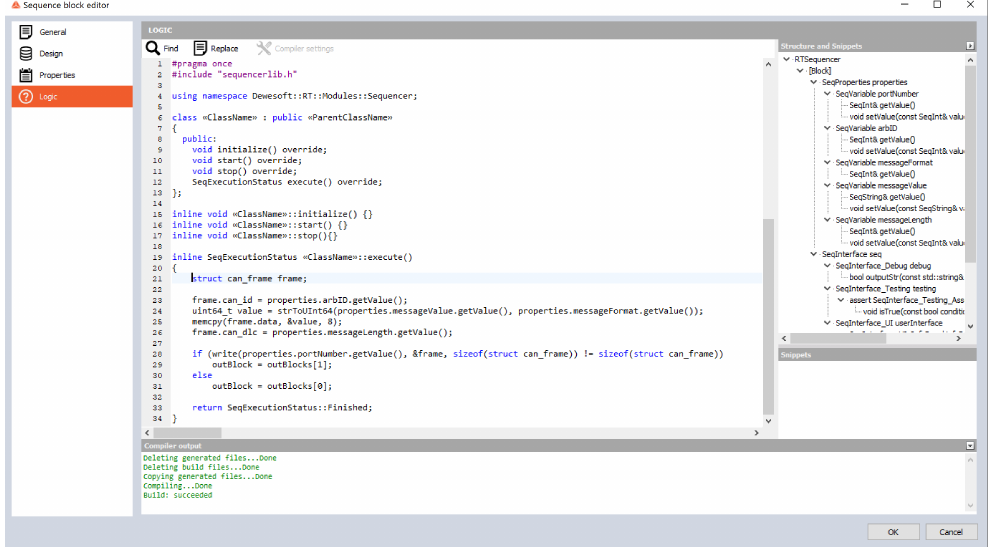
Figure 14. Implementation of a visual block defined by the advanced